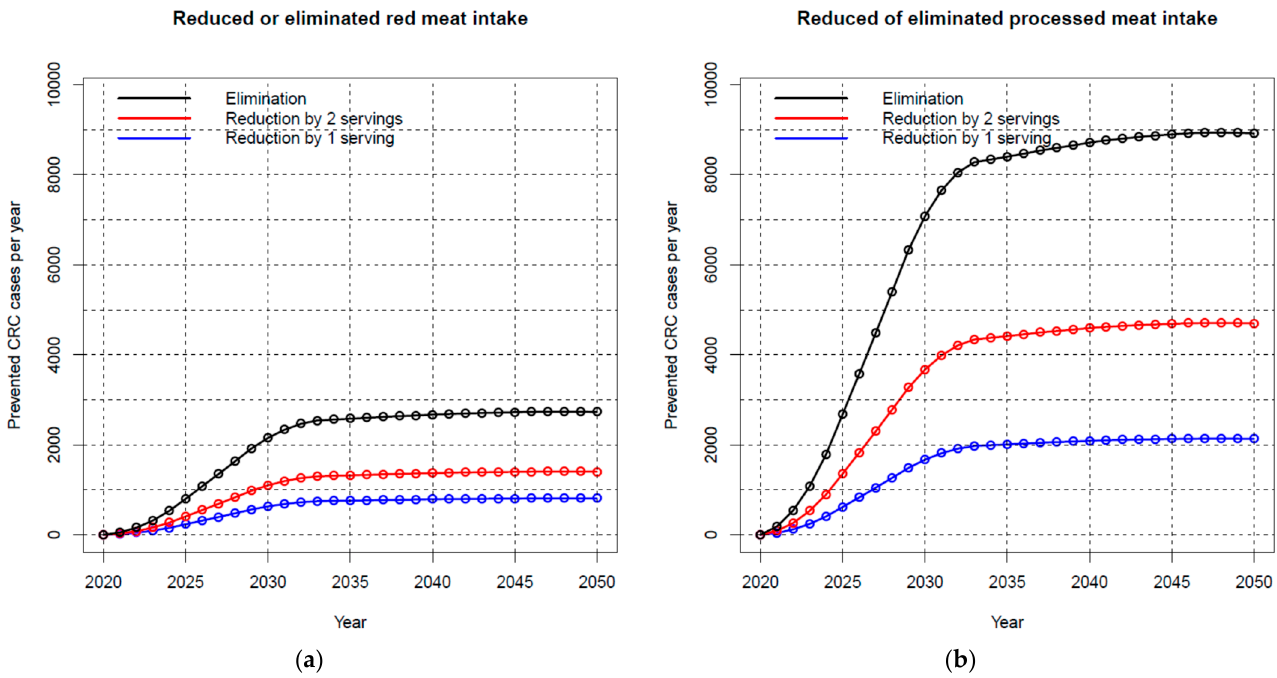
Figure 1. Prevented colorectal cancer cases per year in case of a reduction in consumption of ( a ) red meat and ( b ) processed meat (men and women combined). Abbreviations: CRC, colorectal cancer.